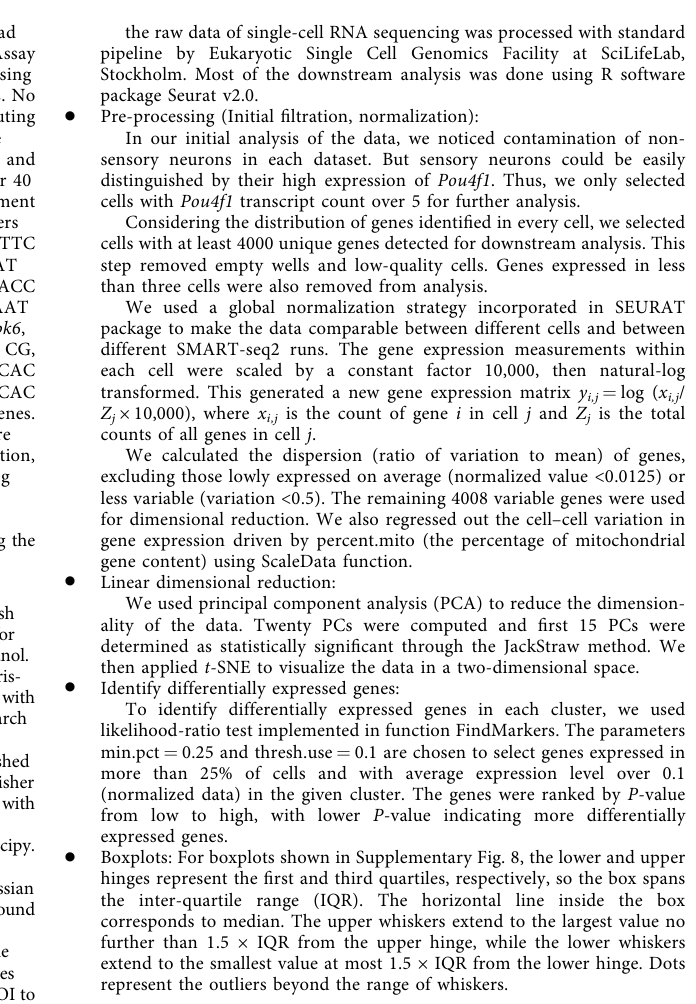
Boxplots: For boxplots shown in Supplementary Fig. 8, the lower and upper hinges represent the fi rst and third quartiles, respectively, so the box spans the inter-quartile range (IQR). The horizontal line inside the box corresponds to median. The upper whiskers extend to the largest value no further than 1.5 × IQR from the upper hinge, while the lower whiskers extend to the smallest value at most 1.5 × IQR from the lower hinge. Dots represent the outliers beyond the range of